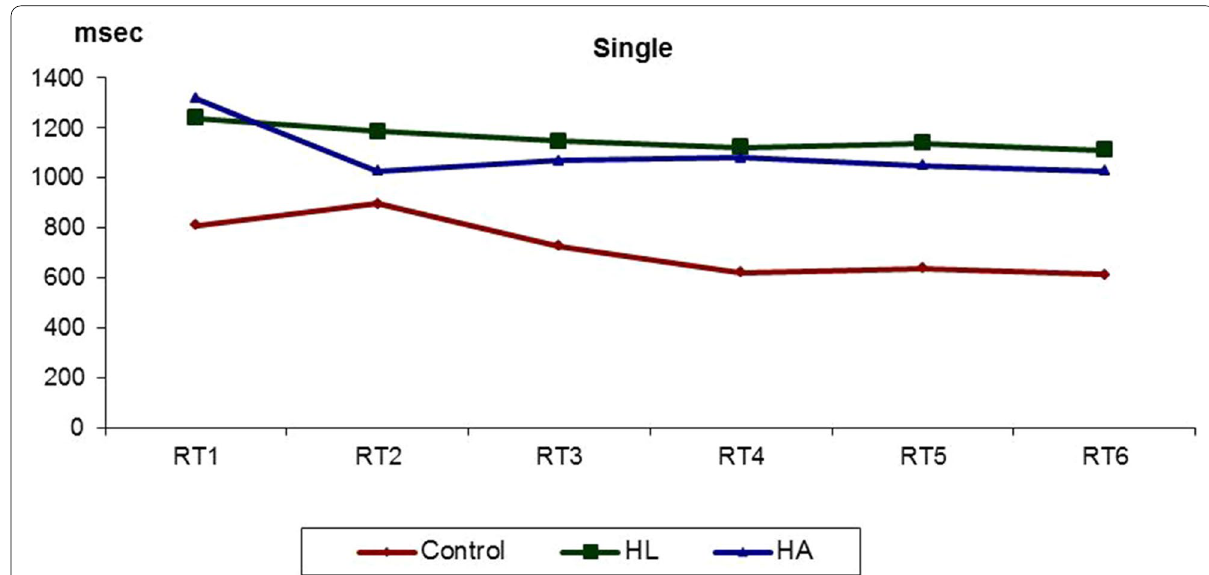
Fig. 1 Comparison of easy task dual condition (reaction times RTs with auditory stimuli) between the control and study subgroups as regards different SNRs